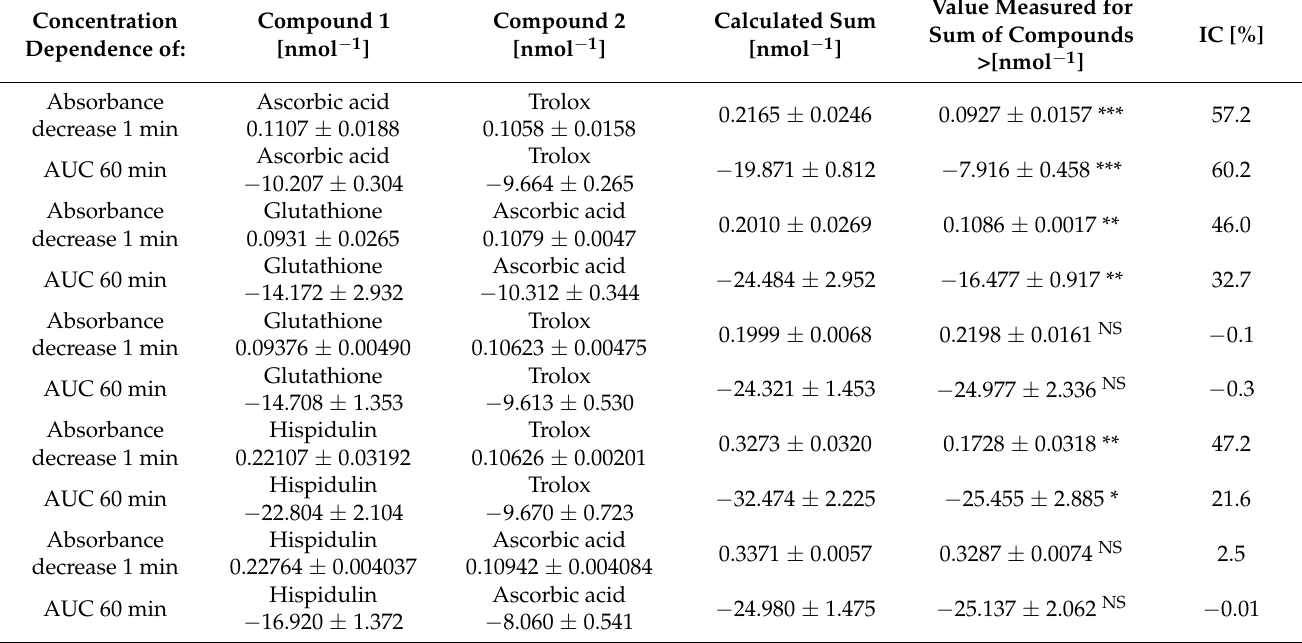
Table 4. Interaction between compounds in the ABTS • decolorization assay as estimated by concen- tration dependence of absorbance decrease after 1 min and concentration dependence of AUC after 60 min. IC, interaction